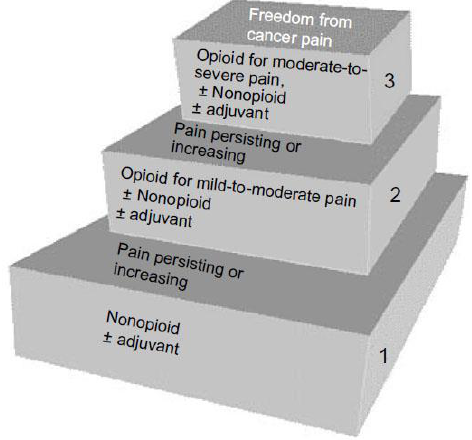
Figure 2. WHO analgesic ladder in cancer pain. Abbreviation: WHO, World Health Organization.